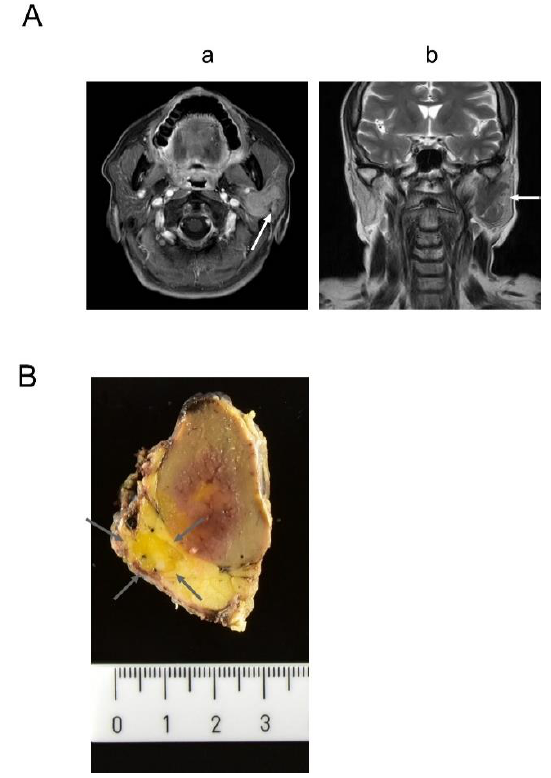
Figure 1. ( A ) Radiological images. ( a ) Gadolinium-enhanced T1-weighted imaging. The arrow shows a well-circumscribed tumor in the left parotid gland. ( b ) T2-weighted imaging. The arrow suggests an aberrant salivary duct. ( B ) Macroscopic images. A well-circumscribed brownish tumor with hemorrhage was seen adjacent to the parotid gland. The arrow shows a clouding yellow cut surface within the parotid gland.